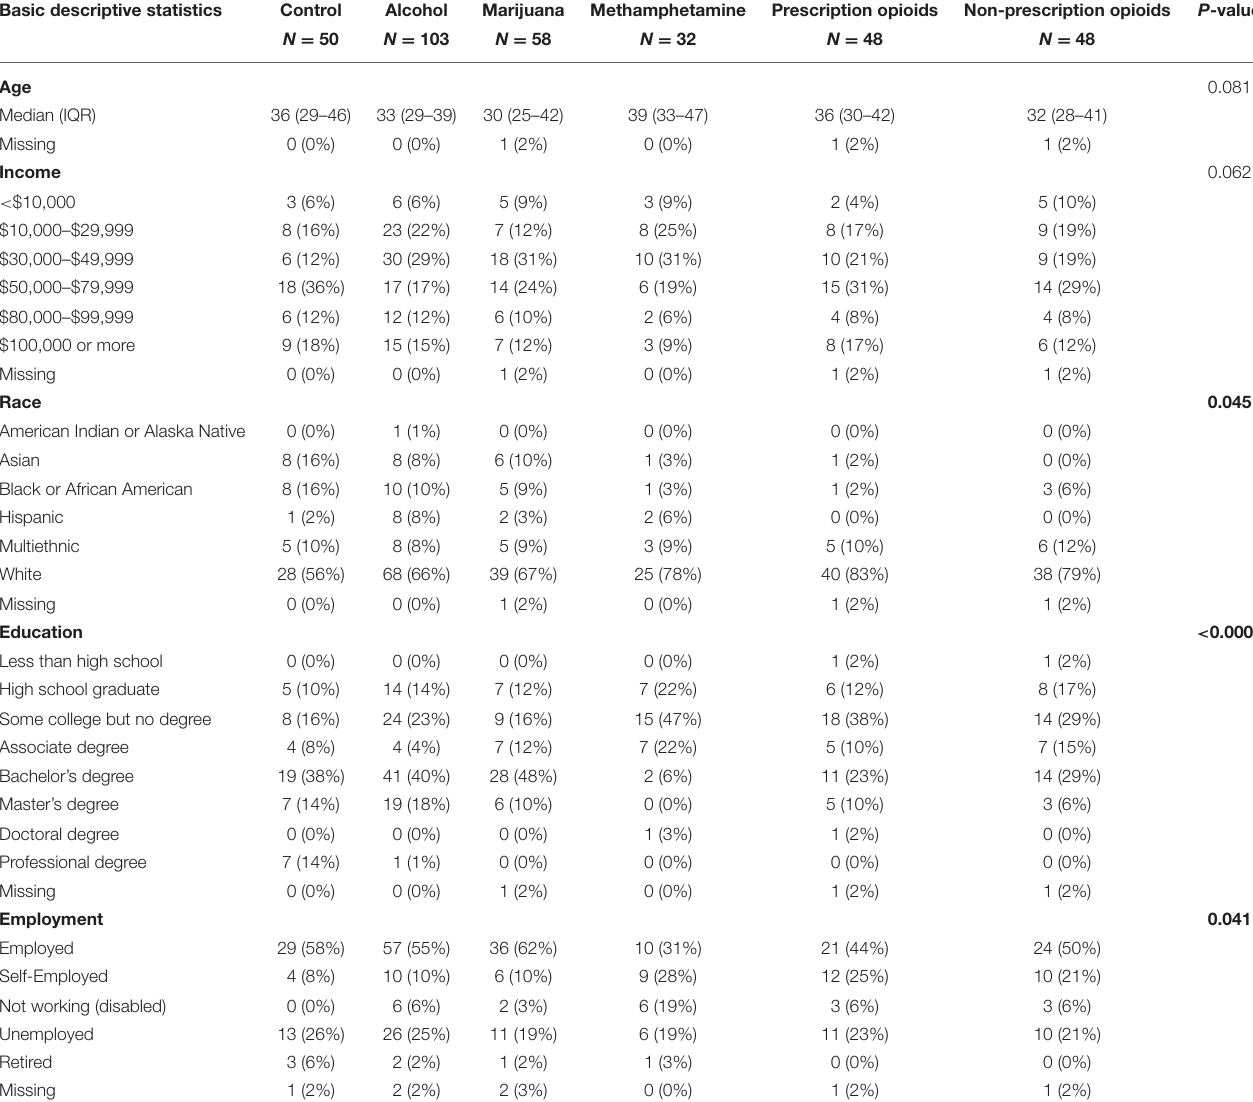
TABLE 1 | Demographic characteristics of the full sample including control participants ( N = 339) by substance of